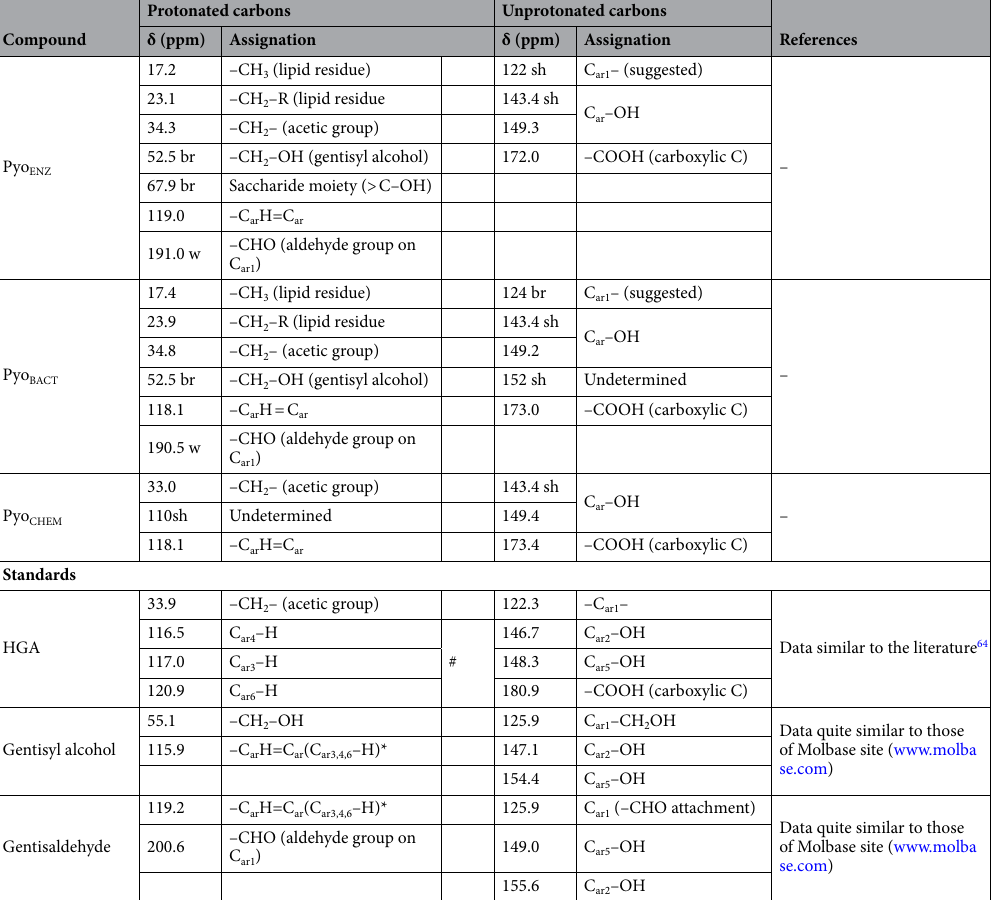
Table 1. Summary of the 13 C CP-MS solid-state NMR chemical shifts and their corresponding assignation for the three pyomelanin pigments, and comparison with standards. Car, aromatic carbon; sh, shoulder; br, broad; w, weak. *Unresolved; # well